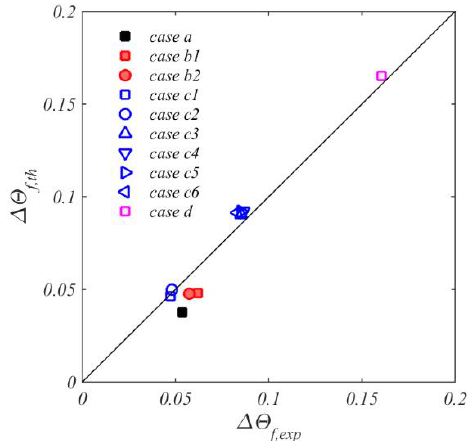
Figure 12 . Comparison between modelled and experimental nondimensional temperature rise of axial throughflow [6].